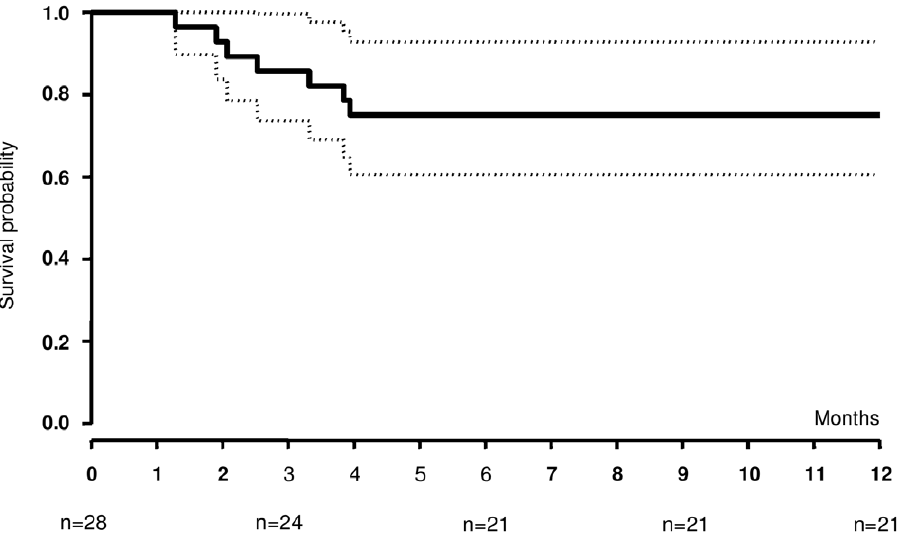
Figure 1. Survival of PML patients on five-drug antiretroviral treatment. Kaplan-Meier estimates and 95% confidence interval of the survival rate during five-drug antiretroviral therapy after PML diagnosis. Baseline is the date of the first dose of enfuvirtide. Follow-up is censored at 12 months. The one-year cumulative probability of survival was 0.75 (95% CI, 0.61–0.93). Seven patients died, all before 4 months.